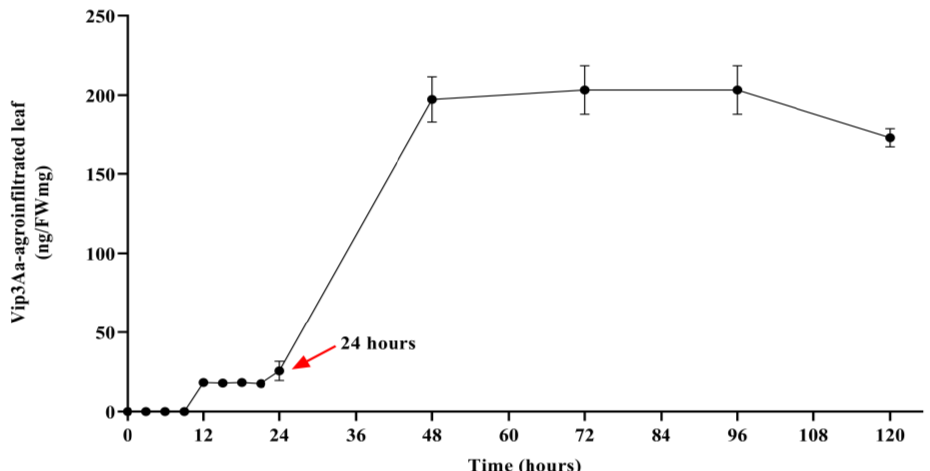
Figure 3. The expression level of Vip3Aa protein in the agroinfiltrated tobacco leaves. The red arrow indicates the starting point of Vip3Aa expression.